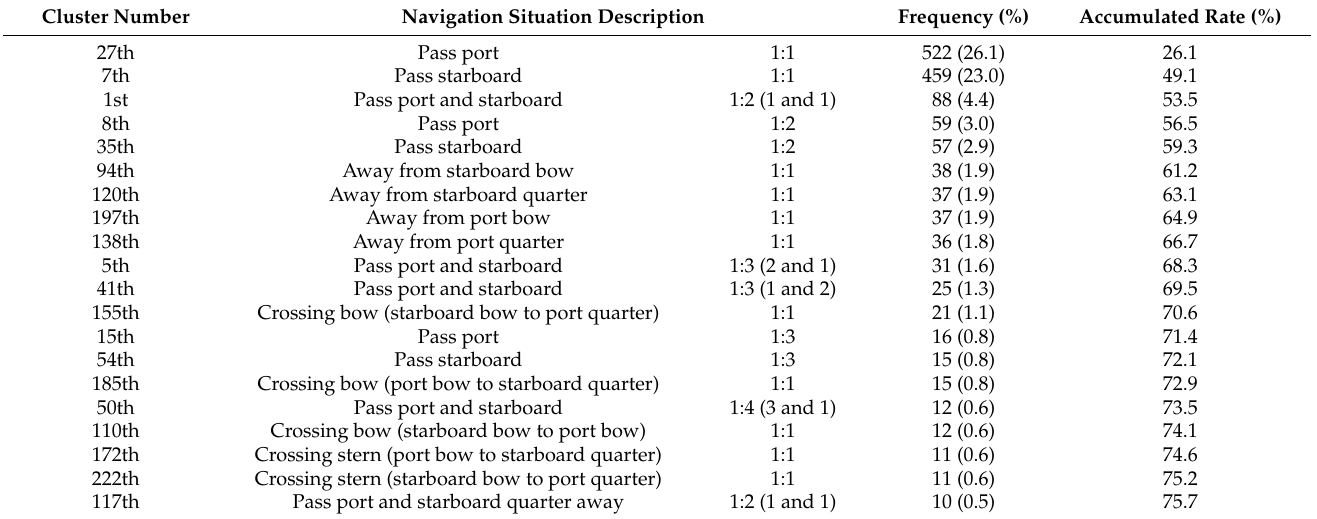
Table 5. Top 20 frequent